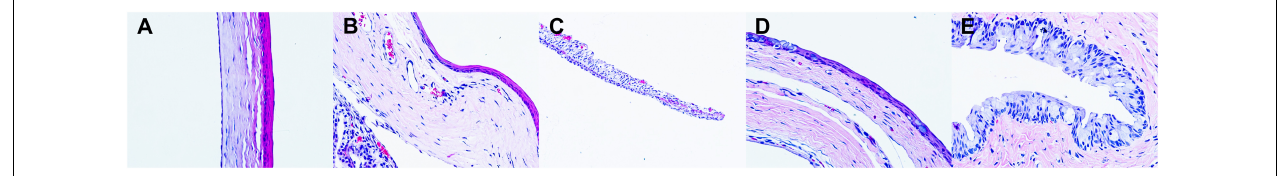
FIGURE 5 | Representative images of H&E staining of ocular tissues on days 7. (A) the cornea; (B) the limbus; (C) the iris; (D) the bulbar conjunctiva; (E) the fornix conjunctiva (magnification: 40 ×